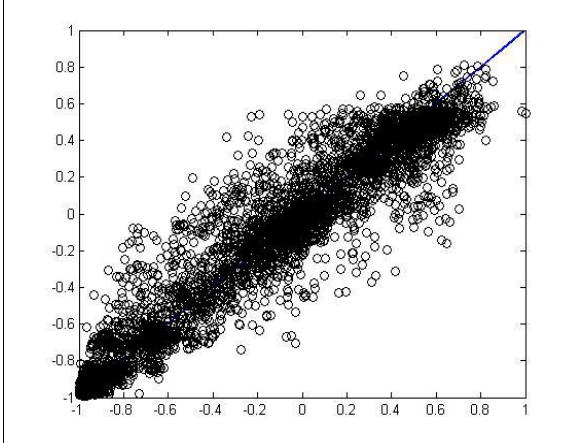
Figure11. Results of training and neural network for training